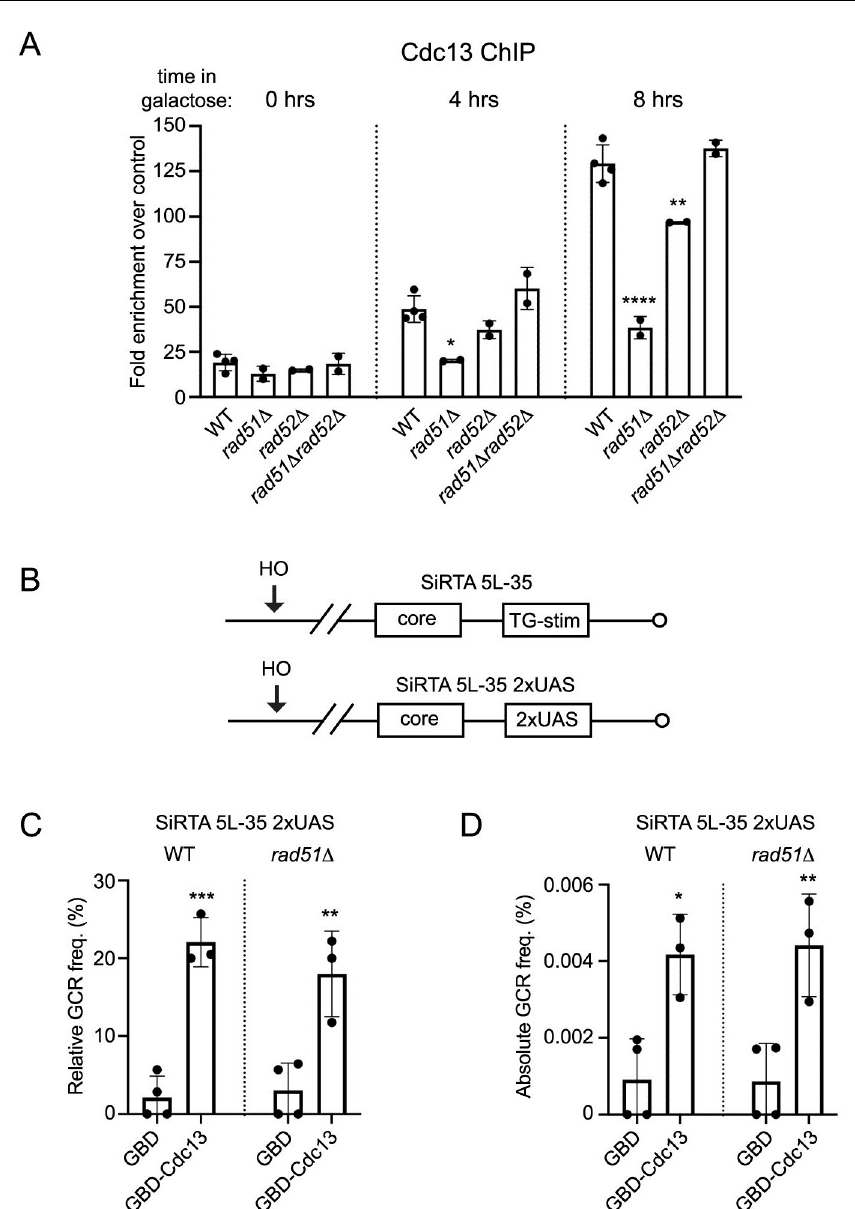
Fig 6. Rad51 promotes the recruitment of Cdc13 to SiRTAs. (A) ChIP analyses of Cdc13 binding at SiRTA 9L-44 in WT, rad51 Δ , rad52 Δ , and rad51 Δ rad52 Δ strains are shown for the indicated timepoints following induction of HO cleavage. SiRTA 9L-44 IP signals are normalized to signal at the control ARO1 locus at the 0 hr timepoint (see Methods). Within a given timepoint, strains that differ significantly from WT by ANOVA with Dunnett’s multiple comparisons test are indicated. (B) Diagram of SiRTA 5L-35 showing the core and TG-stim sequences in an unaltered strain (top). In the experimental strain used in panel C, the TG-stim sequence is replaced with two copies of the Gal4 upstream activating sequence (UAS; bottom). (C) The relative GCR frequency in SiRTA 5L-35 is shown for WT or rad51 Δ strains containing two copies of the Gal4-UAS sequence integrated in place of the SiRTA-Stim. Cells are transformed with vector expressing GBD only (GBD) or vector expressing full-length Cdc13 fused to the Gal4 DNA binding domain (GBD-Cdc13). Data are averages and standard deviations from at least three independent experiments. Averages indicated by asterisks are statistically different from the corresponding GBD control strains by ANOVA with Tukey’s multiple comparisons test. Average relative GCR frequencies measured in the presence of GBD only or GBD-Cdc13 are not different between the WT and rad51 Δ backgrounds. (D) The absolute GCR frequency in SiRTA 5L-35 is shown in the indicated strains from the same experiments shown in panel C. Values are averages from at least 3 independent experiments with standard deviation. Averages indicated by asterisks are statistically different from the corresponding GBD control strains by ANOVA with Tukey’s multiple comparisons test. Average absolute GCR frequencies measured in the presence of GBD only or GBD-Cdc13 are not different between the WT and rad51 Δ backgrounds. ( � p < 0.05; �� p < 0.01; ��� p < 0.001; ���� p < 0.0001).